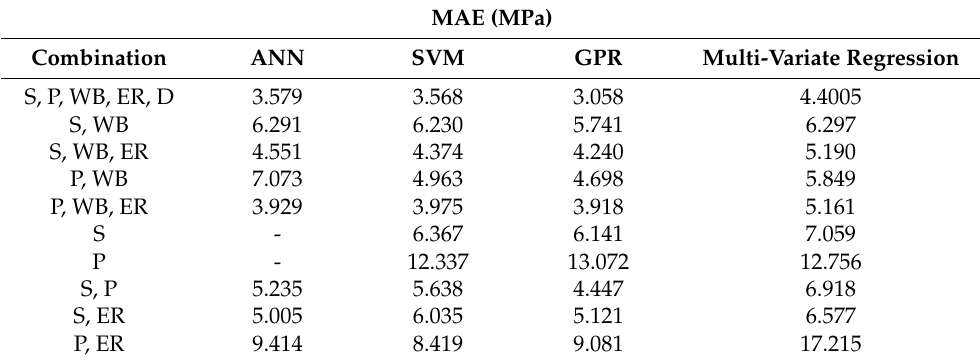
Table 11. C omparison of RMSE between the different methods used in the study.